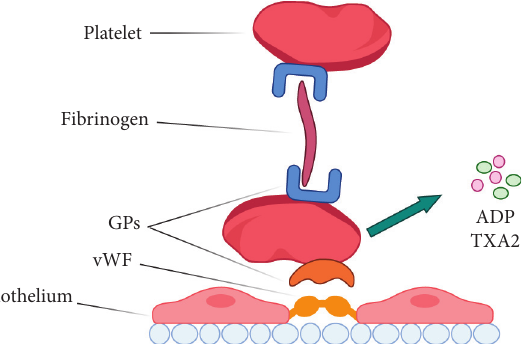
Figure 2: The primary process of hemostasis. The adhesion and aggregation of mediated by von Willebrand factor (vWF) and glycoproteins (GPs), and the release of ADP and TXA2.